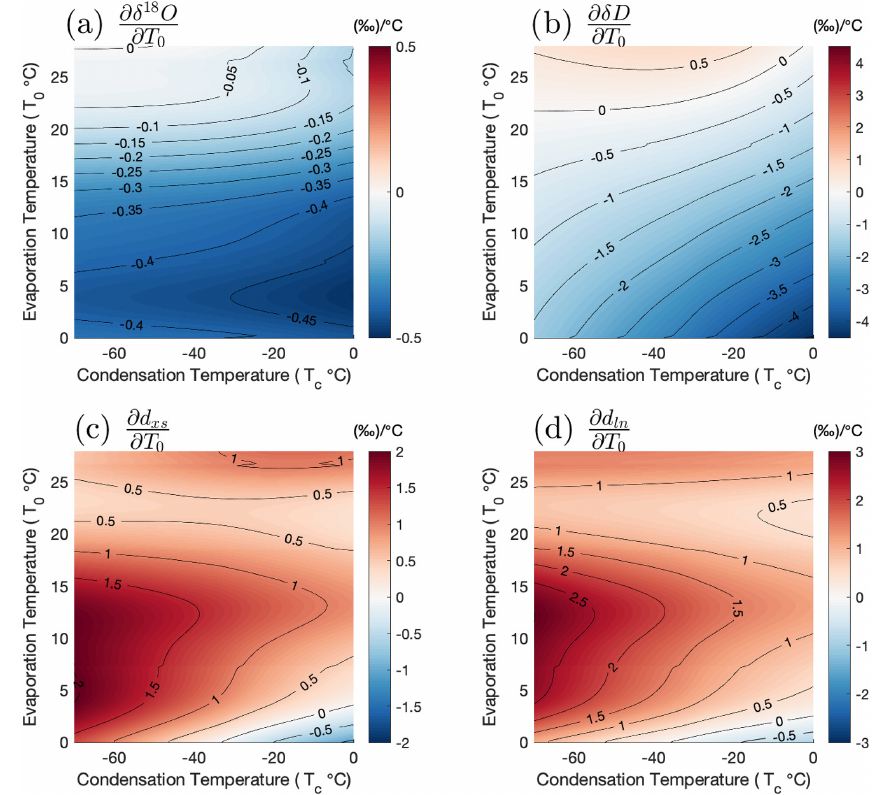
18 O , (b) ∂δ D , (c) ∂d xs , (d) ∂d ln . Shading ∂T 0 ∂T 0 ∂T 0 ∂T 0